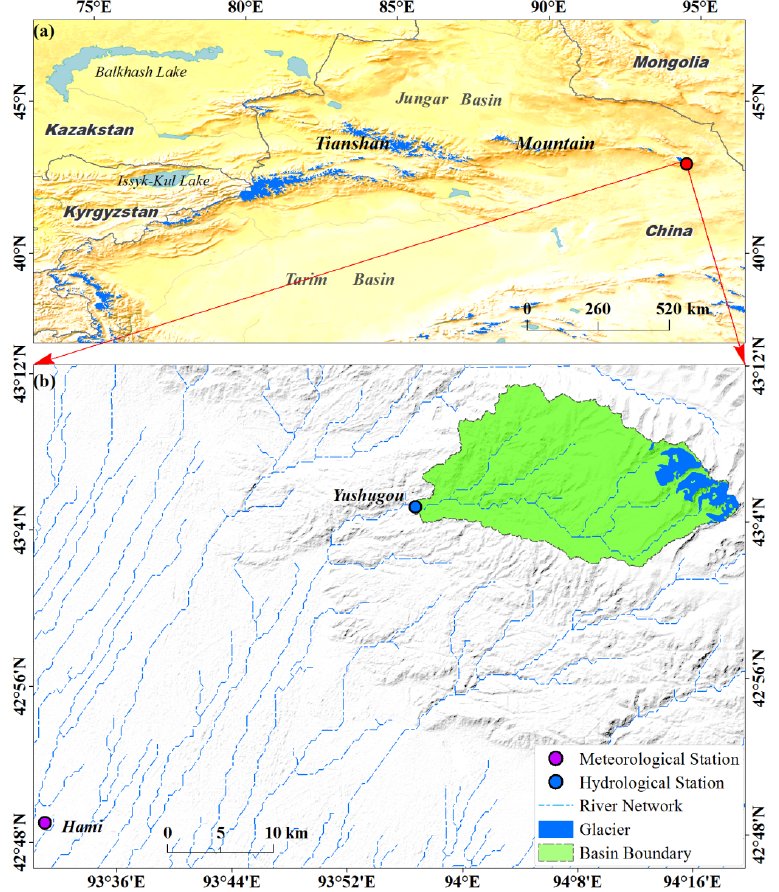
Figure 1. Map of the location of Yushugou Basin ( a ), sites of the hydrological station and meteorological station ( b ).